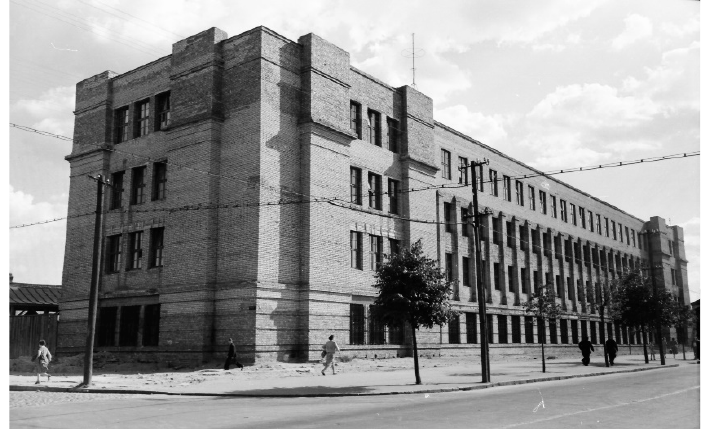
Figure 15. View of the wing along Savanori ų Avenue, 1959 (photographer Stanislovas Lukošius, source: Kaunas City Museum).